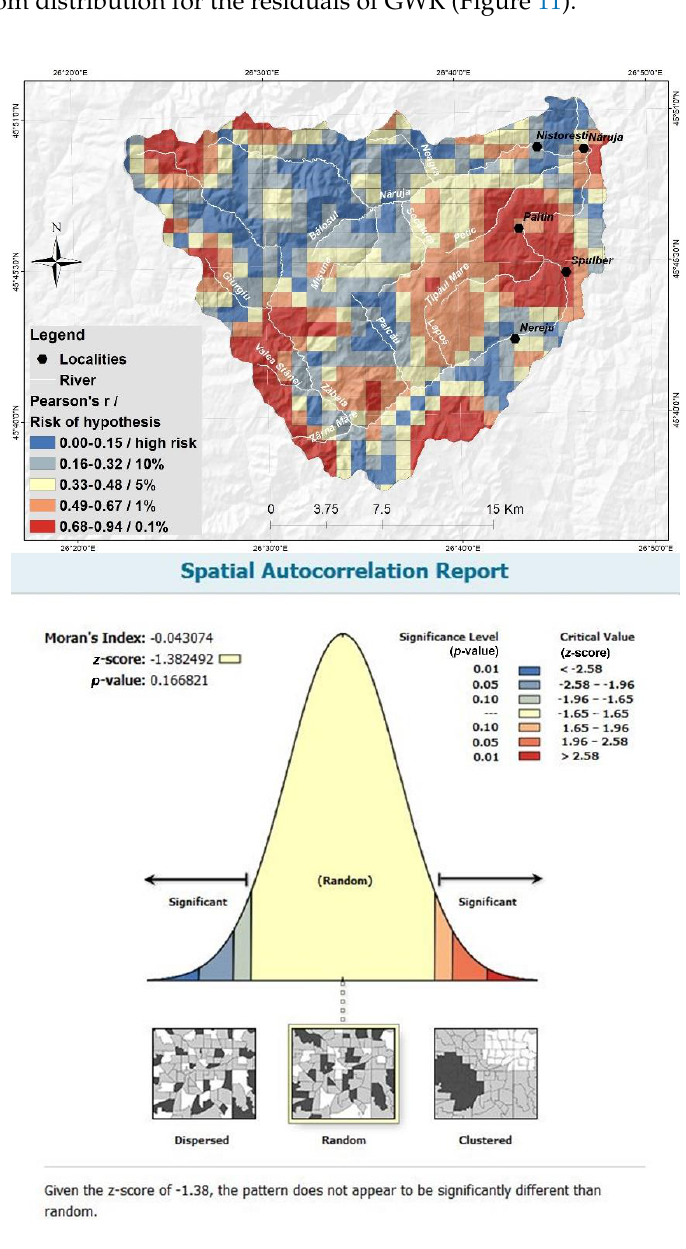
Figure 11. Spatial distribution of the r correlation coefficient for GWR and Moran’s spatial autocorrelation report on GWR residuals.